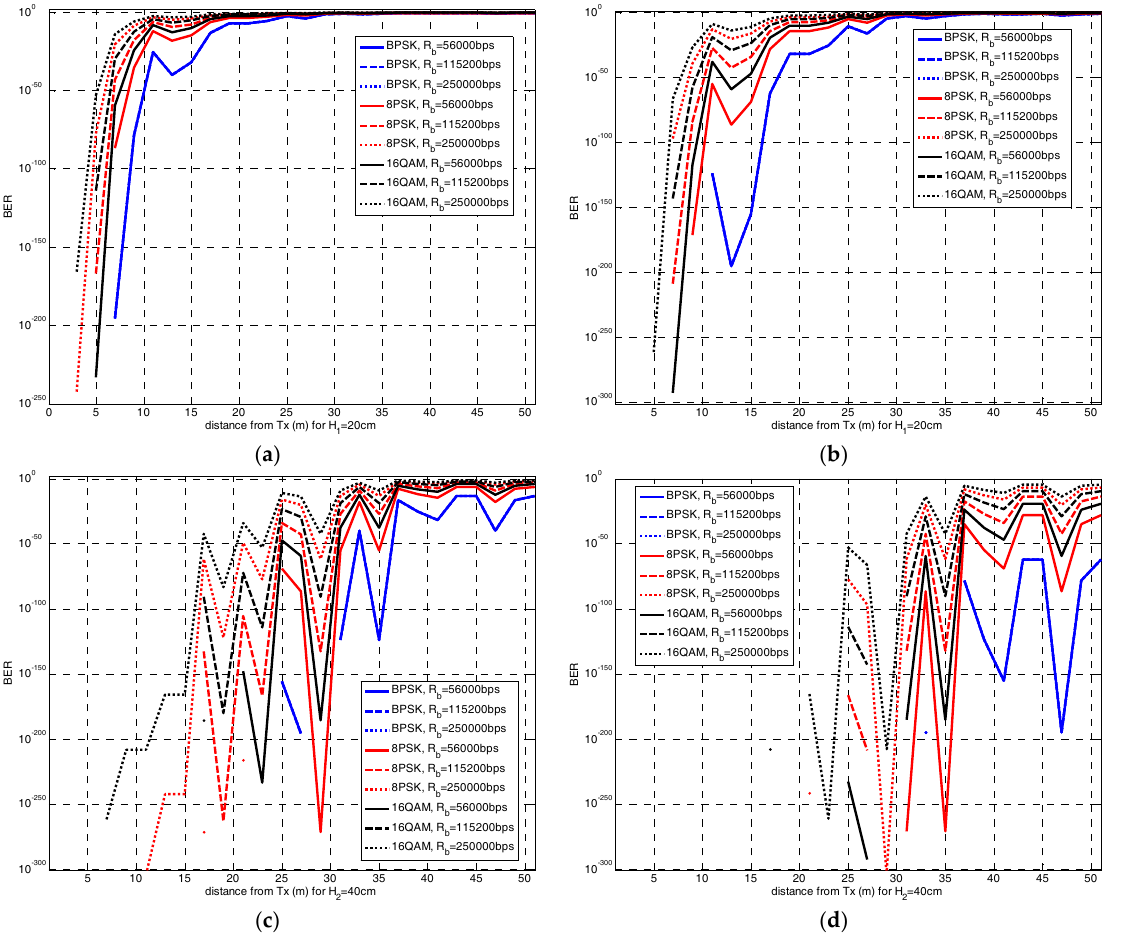
Figure 6. BER for ( a ) H 1 and B = 100 MHz; ( b ) H 1 and B = 100 MHz; ( c ) H 2 and B = 20 MHz; ( d ) H 2 and B = 20 MHz.